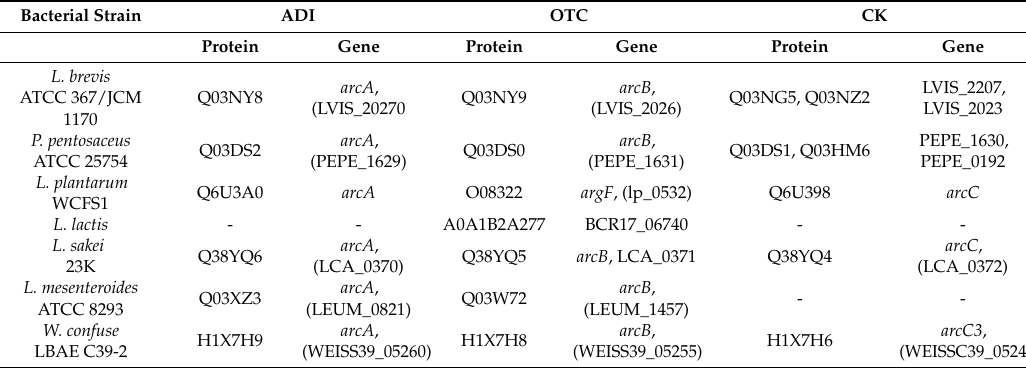
Table 1. Characterization of the ADI system in lactic acid bacteria.